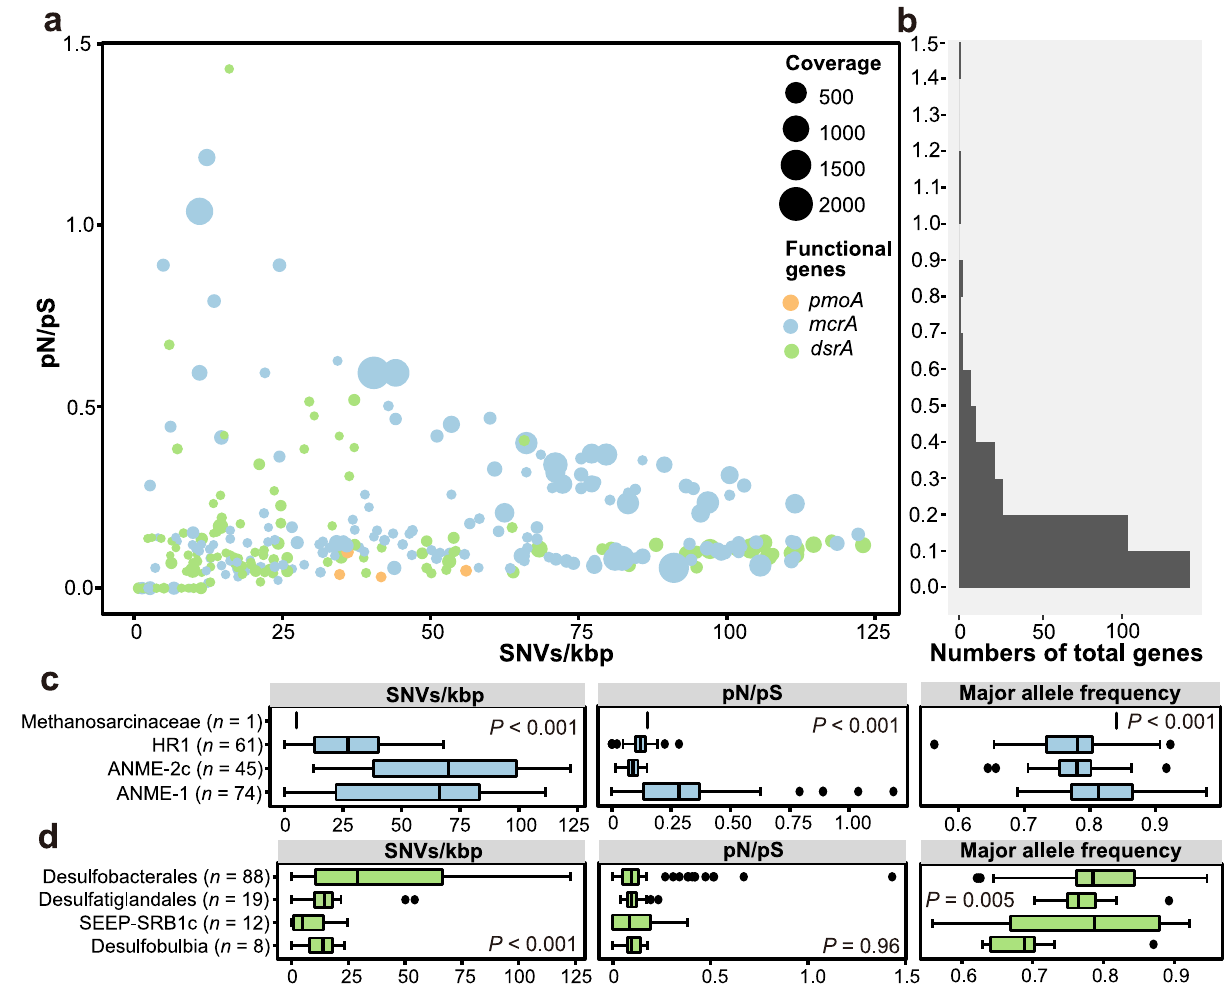
Fig. 5 | Gene-speci fi c evolutionary metrics of three key functional microbial groupsincold seep sediments.a Relationships between SNV density, pN/pS,and gene coverage for pmoA , mcrA , and dsrA . Each dot represents one species-level microbial population. b Frequency histogram of pN/pS for pmoA , mcrA , and dsrA . c , d Comparison of SNV density, pN/pS, and major allele frequency of dsrA and mcrA genes across different taxonomic groups of SRB and ANME, respectively. P